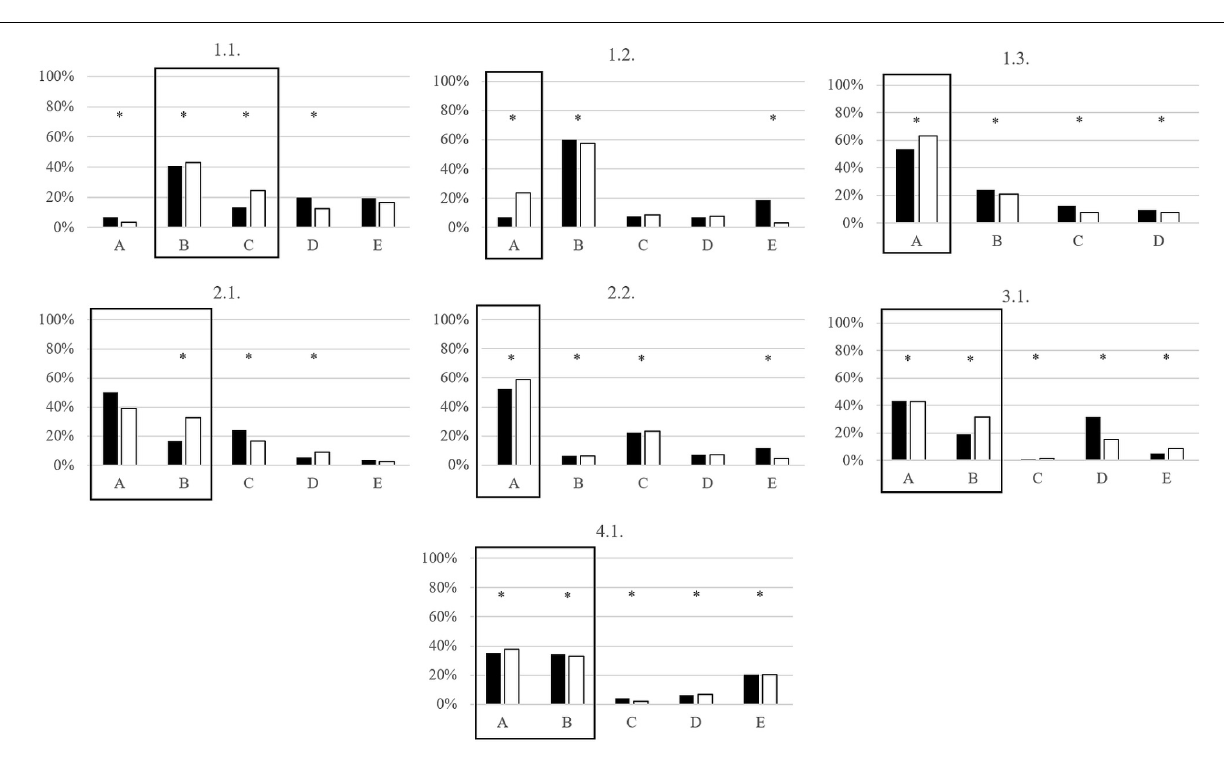
FIGURE 2 | Relative frequencies obtained for each question: (cid:4) pretest; (cid:3) posttest. Questions with significant differences between pre and posttests are marked with ∗ (Correct answers are marked with a